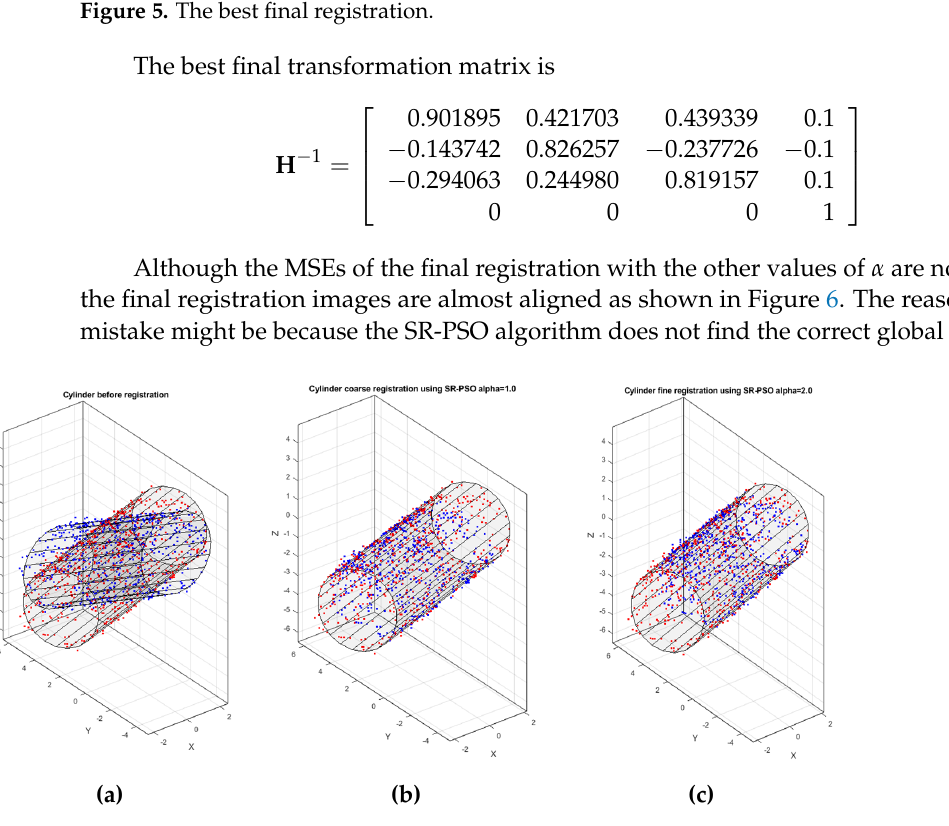
Figure 6. ( a ) The superimposed image before registration, the final registration with α is equal to ( b ) 1.0, and ( c ) 2.0.